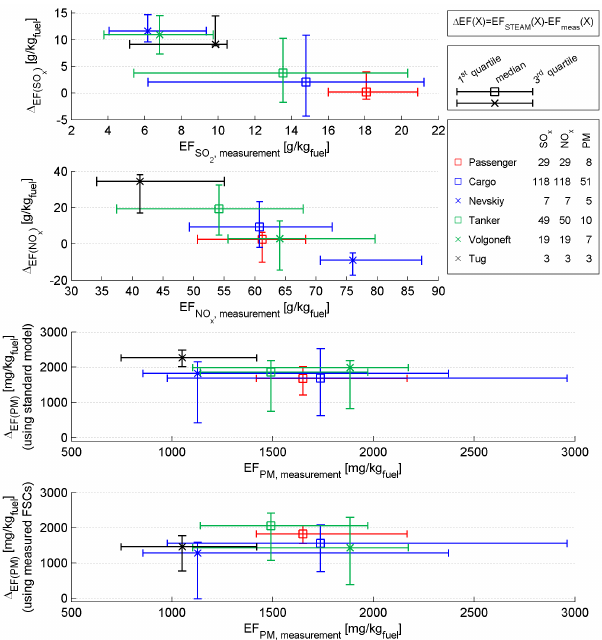
Figure 10. Comparison between modeled data by STEAM and measured data. The differences of the emission factors are shown group-wise for individual ships at same speed. Thus it is shown in the graphs by how much the STEAM model statistically exceeds the measured data. It should be considered that the modeled SO x was compared to the measured SO 2 . Furthermore, the sum of the mod- eled emissions of organic carbon, elemental carbon, ash and SO 4 are compared to the measured size-distributed data between 5.6nm and 10µm under the assumption of a particle density of 1gcm − 3 , which were calculated using the FSCs originally assumed by the model and the FSCs obtained from the measurements. The number of the compared plumes for each type and species is presented by the number values in the